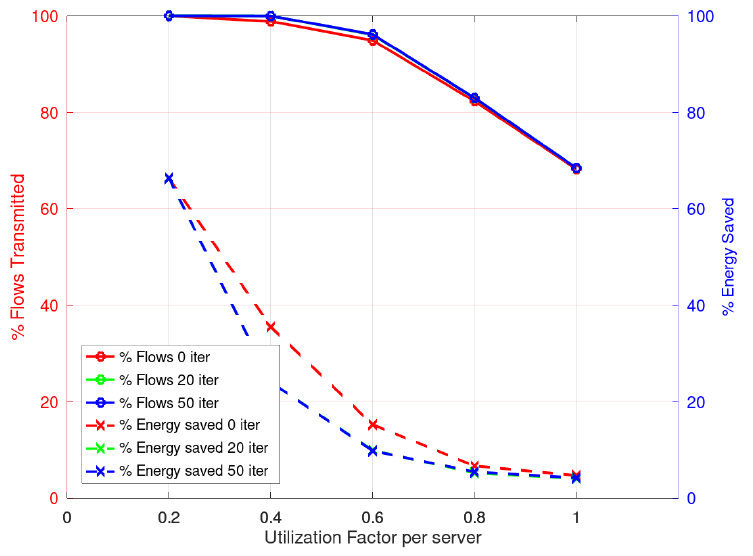
Figure 8. Multistart ad-hoc heuristic, flow scheduling.